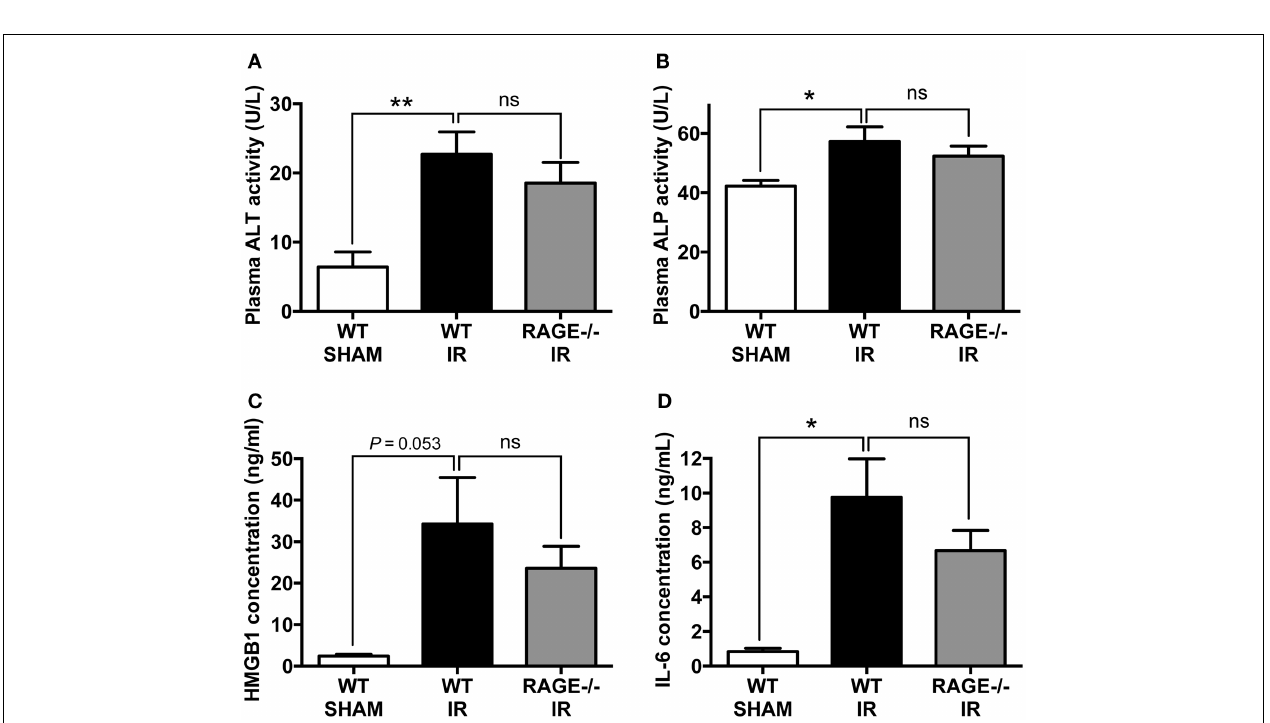
FIGURE 4 | Elimination of RAGE does not influence remote organ (liver) injury and systemic inflammation following intestinal IR . Mice were subjected to 30min mesenteric artery occlusion, followed by 150min reperfusion. Peripheral blood samples were collected from WT-SHAM, WT-IR, and RAGE (cid:0) / (cid:0) IR groups for enzyme activity and pro-inflammatory markers. (A,B) Activities of liver enzymes ALT (A) and ALP (B) measured as markers of liver injury. (C,D) Levels of pro-inflammatory mediators HMGB-1 (C) and IL-6 (D) . Data are presented as mean (cid:6) SEM, n = 5 (WT-SHAM); n = 13 (WT-IR); n = 15 (RAGE (cid:0) / (cid:0) IR) where * p < 0.05, ** p < 0.01, and ns = not-significant ( p >